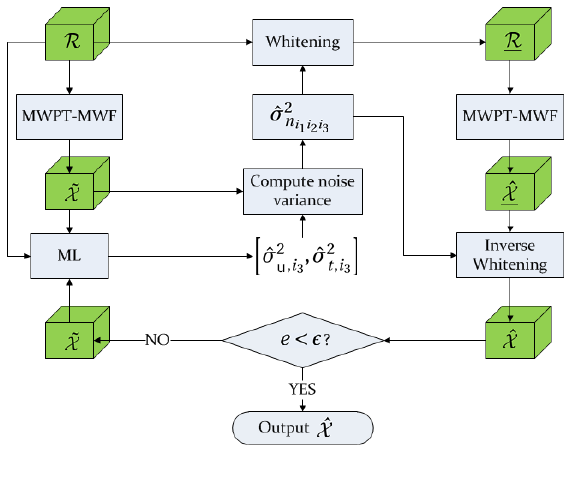
Figure 1. Flowchart of the SDNW-MWPT-MWF algorithm.